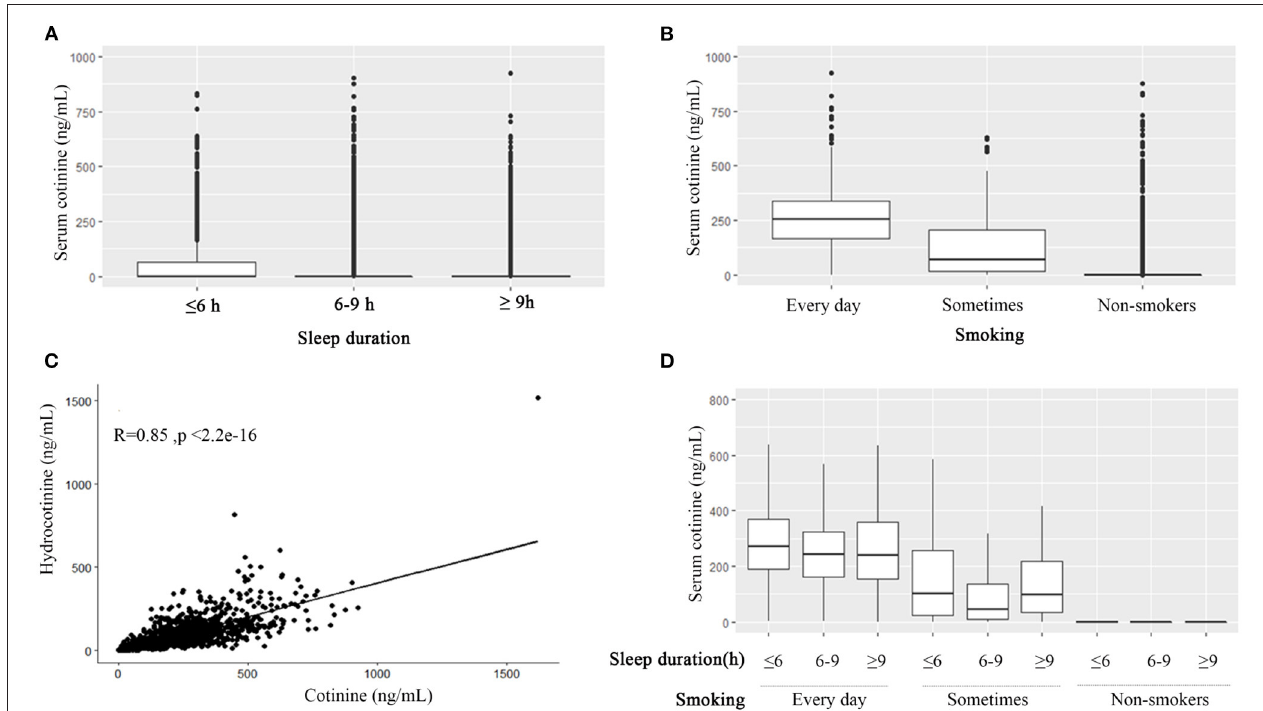
FIGURE 1 | The association among smoking, cotinine, hydrocotinine, and sleep duration. Boxplots of serum cotinine levels grouped by sleep duration ( ≤ 6, 6–9, and ≥ 9h) (A) , grouped by smoking frequency (B) , and grouped by sleep duration and smoking frequency (D) . (C) The scatter plot of cotinine and hydrocotinine with the Pearson correlation r =